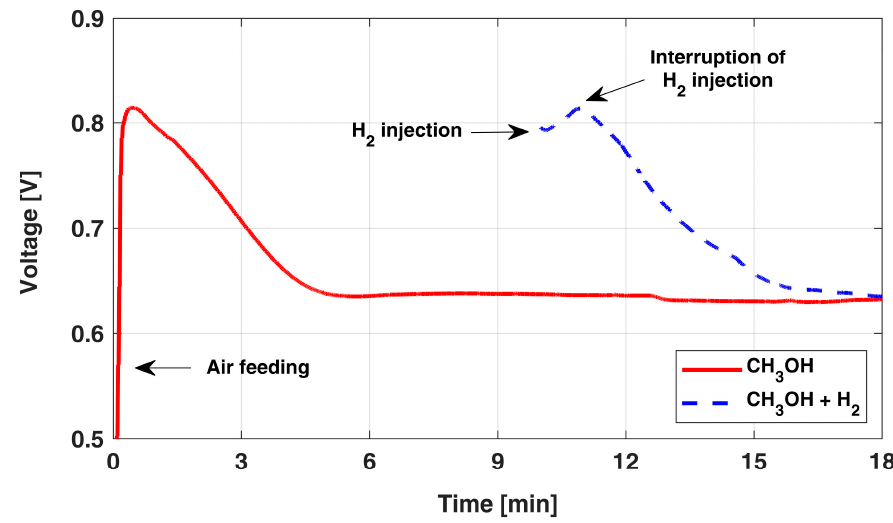
Figure 1. OCV overshoot behavior after the start of airflow and after H2 injection. The data are adapted from [12] with authors’ permission.